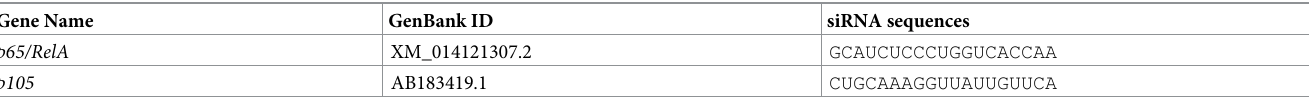
Table 2. Sequences for siRNA